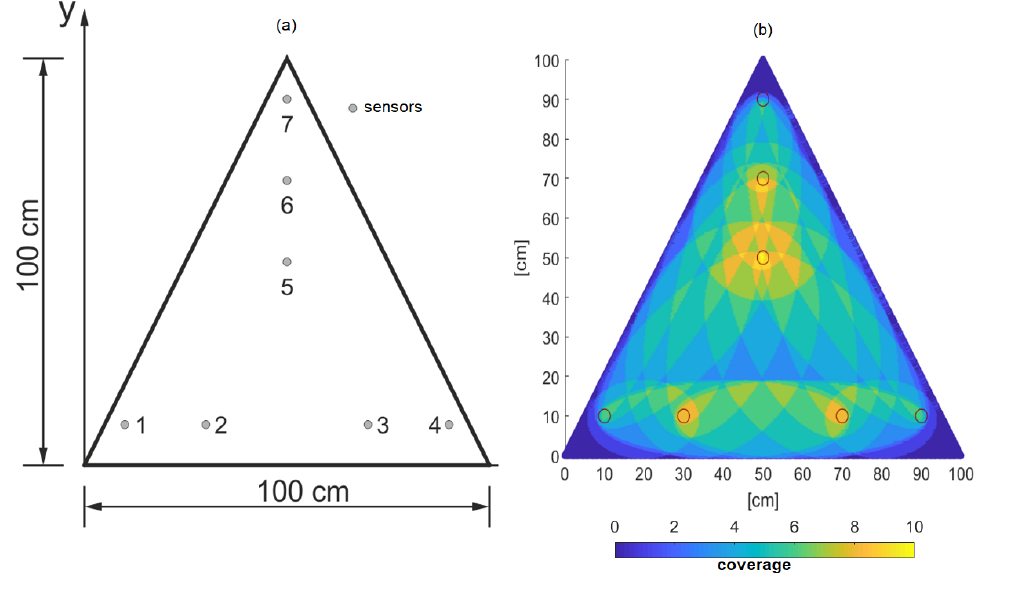
Figure 15. ( a ) Geometry and arrangement of piezoelectric transducers in the triangular aluminum plate; ( b ) Surface plot showing coverage for the triangular